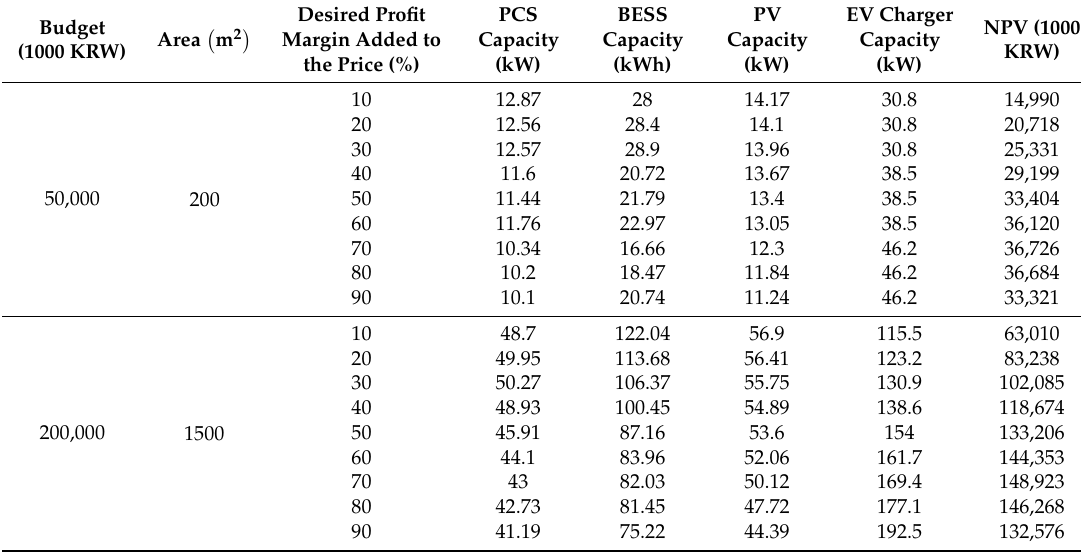
Table 7. Simulation results for Case A with base unit prices of equipment.